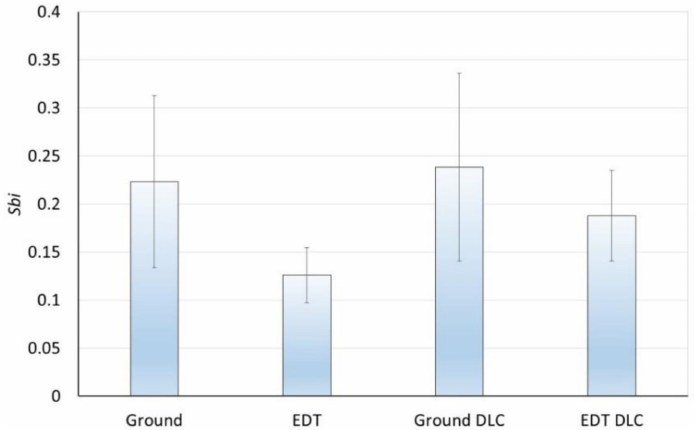
Figure 6. Sbi values for the different surface